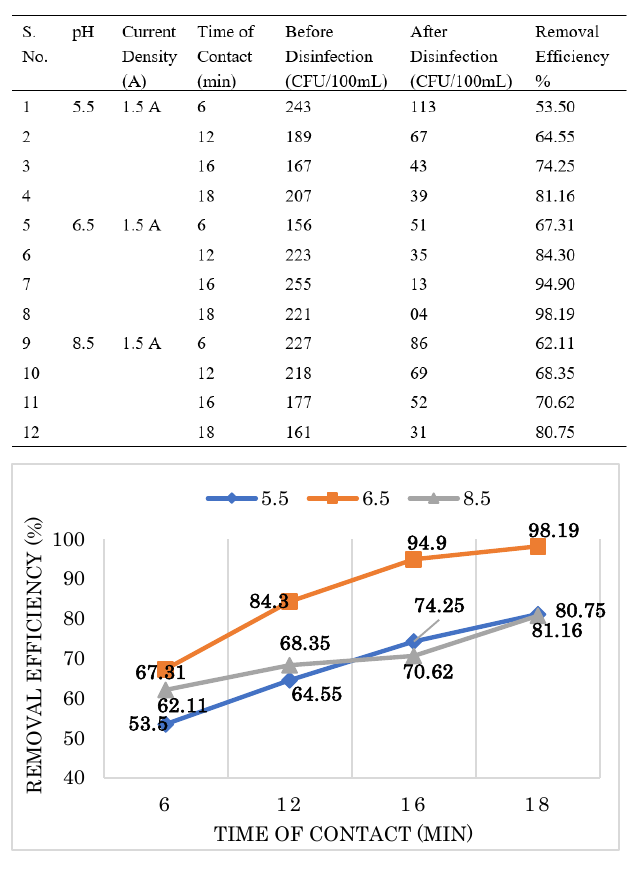
Fig. 7. Time optimization for total coliform removal for 1.5 A